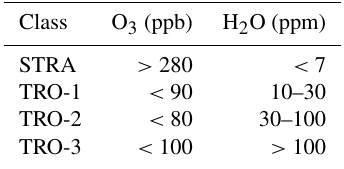
Table 1. Thresholds used for the air mass classification of tropo- spheric and stratospheric air in T–T space (see also Fig.